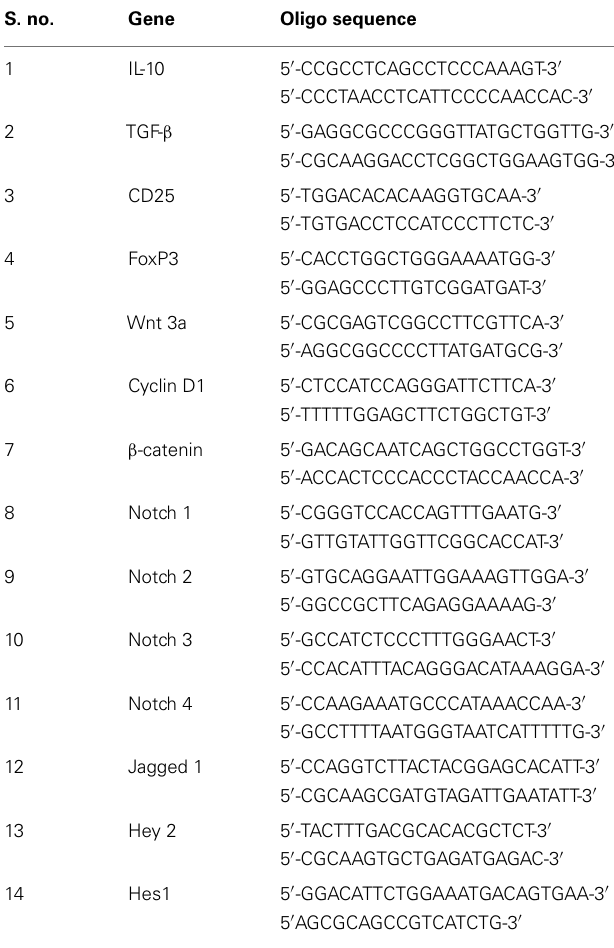
Table 1 | Oligo sequences used in the study for quantitative RT-PCR . S.